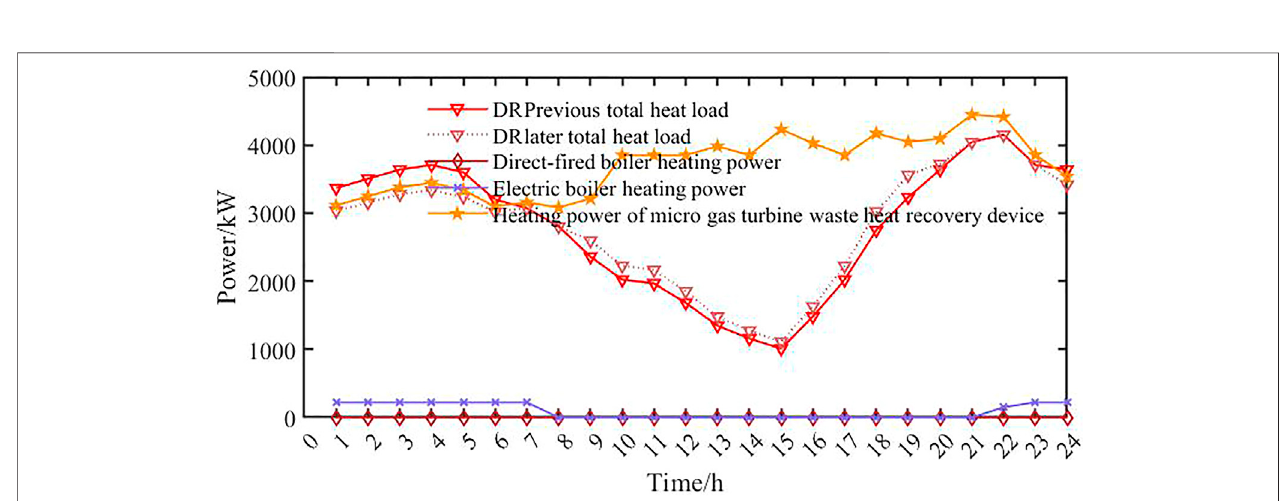
FIGURE 8 | Planned values of heat power items during the day to be